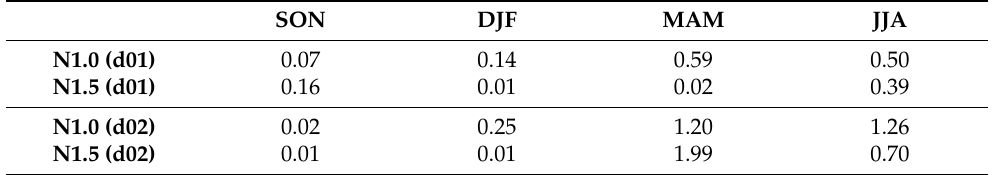
Table 1. Interannual variability score (IVS) of the domain-mean TSTORM simulated by N1.0 and N1.5 ensemble mean in the two domains. Zero IVS is the perfect match between model and reference data. SON DJF MAM JJA N1.0 (d01) 0.07 0.14 0.59 0.50 N1.5 (d01) 0.16 0.01